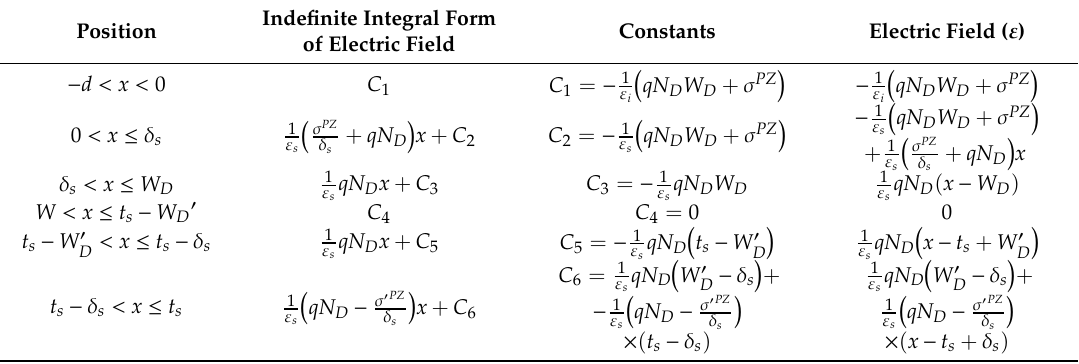
Table A7. Derivations of electric field distribution of the piezoelectric MIS structure.